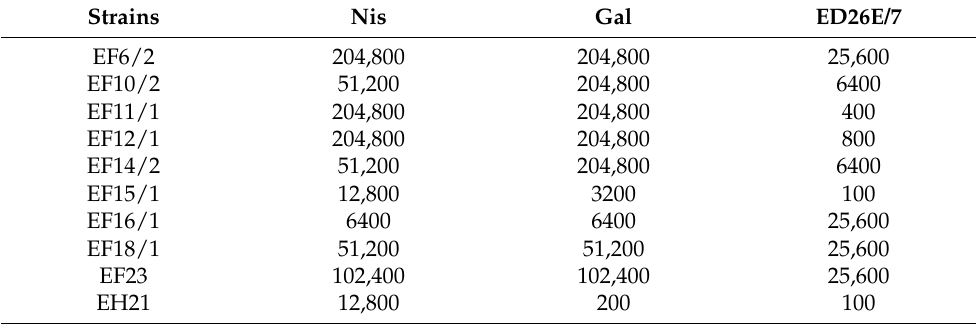
Table 3. Susceptibility of enterococci from raw goat milk to bacteriocins